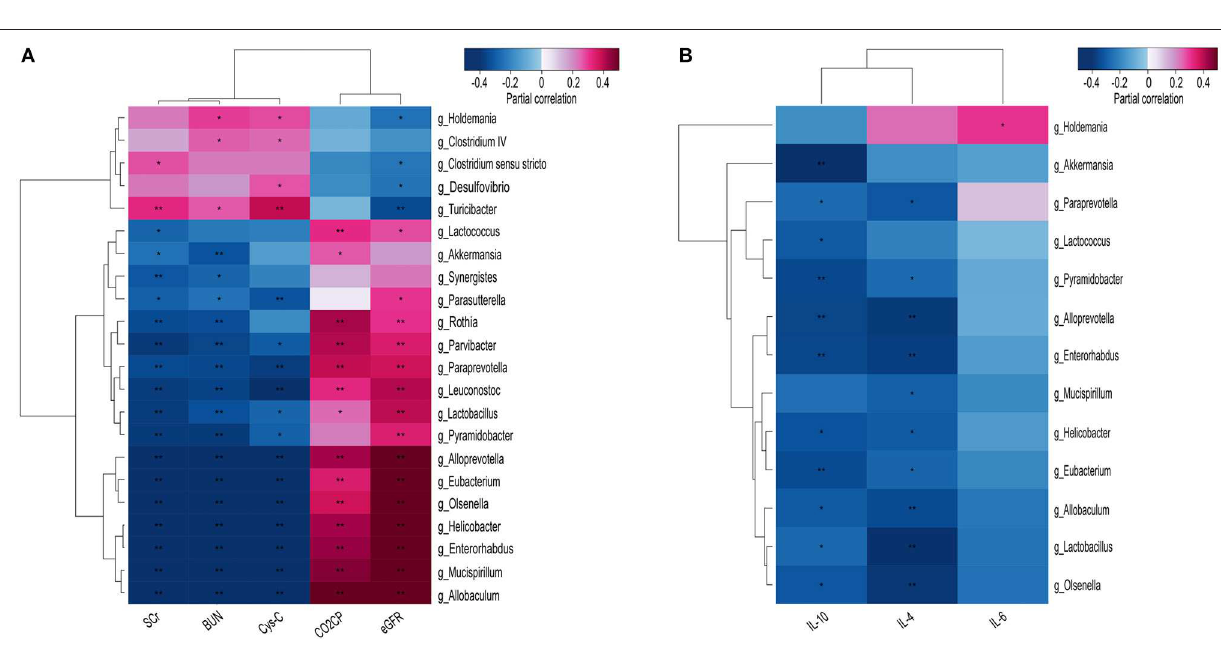
FIGURE 4 | Heatmaps showing correlations between differentially abundant microbiota genera and chronic kidney disease (CKD) clinical parameters. Correlations were demonstrated between various differentially abundant fecal microbiota genera and (A) the specified CKD clinical characteristics, and (B) the production of inflammatory cytokines. BUN, blood urea nitrogen; CO 2 CP, carbon dioxide combining power; CysC, Cystatin C; eGFR, estimated glomerular filtration rate; IL, Interleukin; SCr, Serum creatinine. Spearman test, * P < 0.05, ** P <